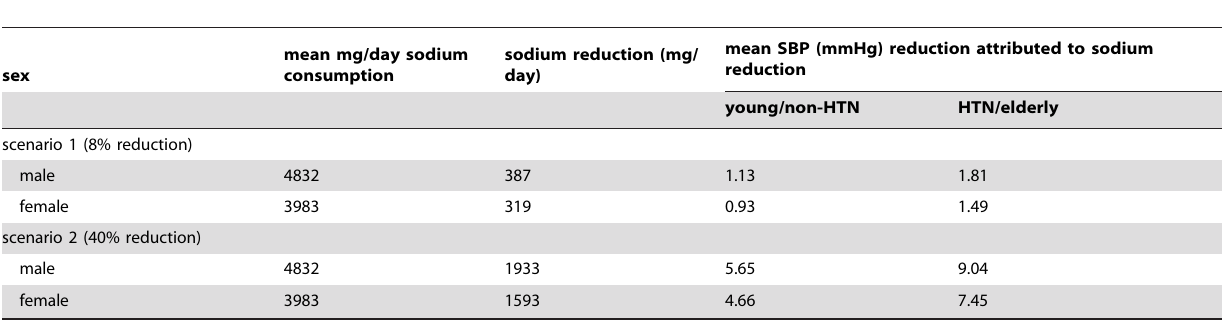
Table 2. Mean sodium consumption by age groups and sex and mean reduction of systolic blood pressure reducing 8% the sodium consumption (Scenario 1) and 40% the sodium consumption (Scenario 2).